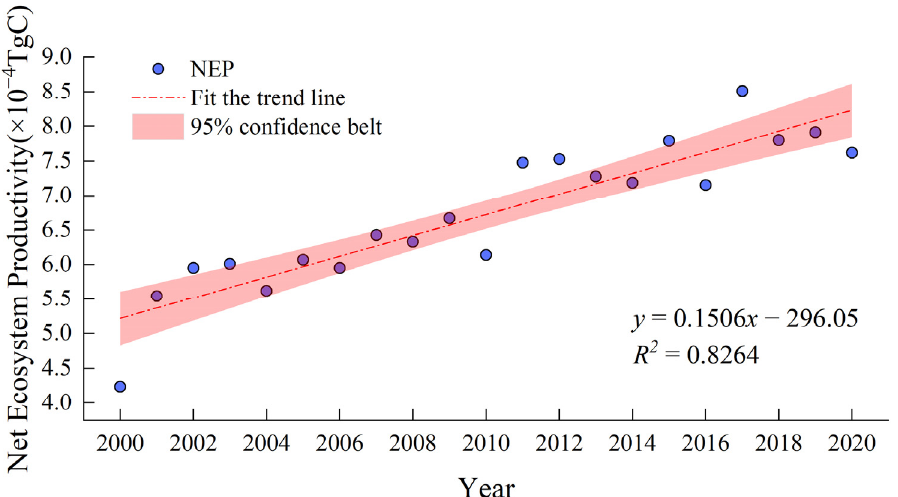
Figure 4. Temporal rate of variation in the total NEP in the Yellow River basin, 2000–2020 (Scatter plot of NEP total amount year by year, including linear fitting trend and 95% confidence interval).